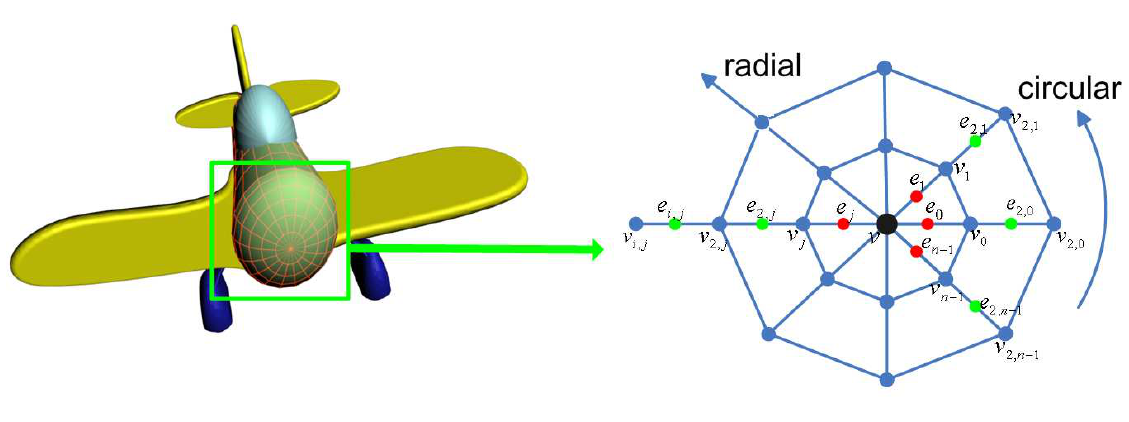
Figure 2. Polar control net near an extraordinary point. v denotes the vertex in polar net and e denotes the edge point. The control points have subscripts i which indicates the radial dis- tance to the extraordinary point, subscripts j (modulo valence n) which indicates the circular index. v and e is written as v and e for 1 ,j 1 ,j j j